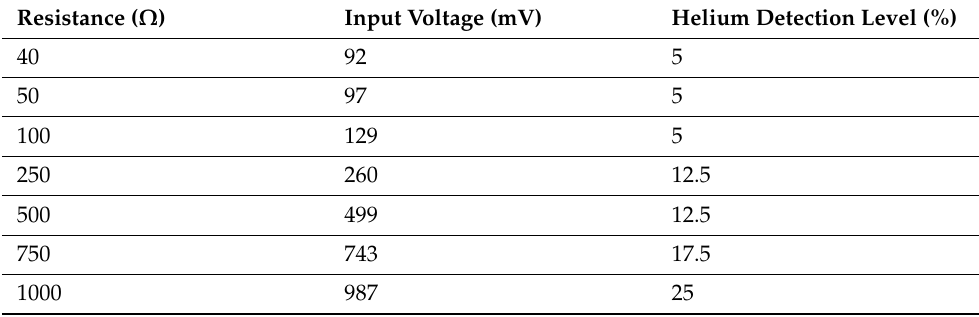
Table 3. The effect of the resistance on the input voltage and helium detection level. Table 3. The e ff ect of the resistance on the input voltage and helium detection level. Resistance ( Ω Resistance ( Ω )